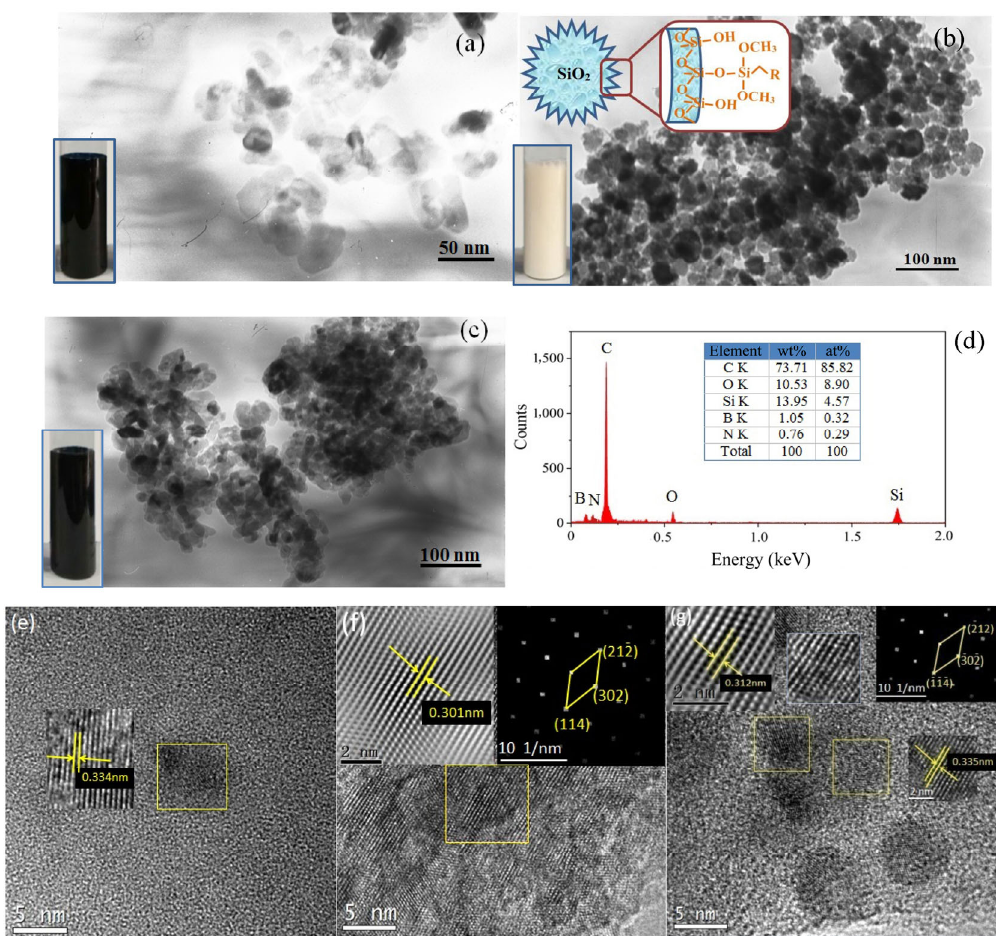
Fig. 2 Photographs of the PAO lubricant with nanoparticles and TEM/HTEM images, respectively. (a, e) B–N–GO, (b, f) SiO 2 , and (c, g) SiO 2 –B–N–GO with (d) the EDX